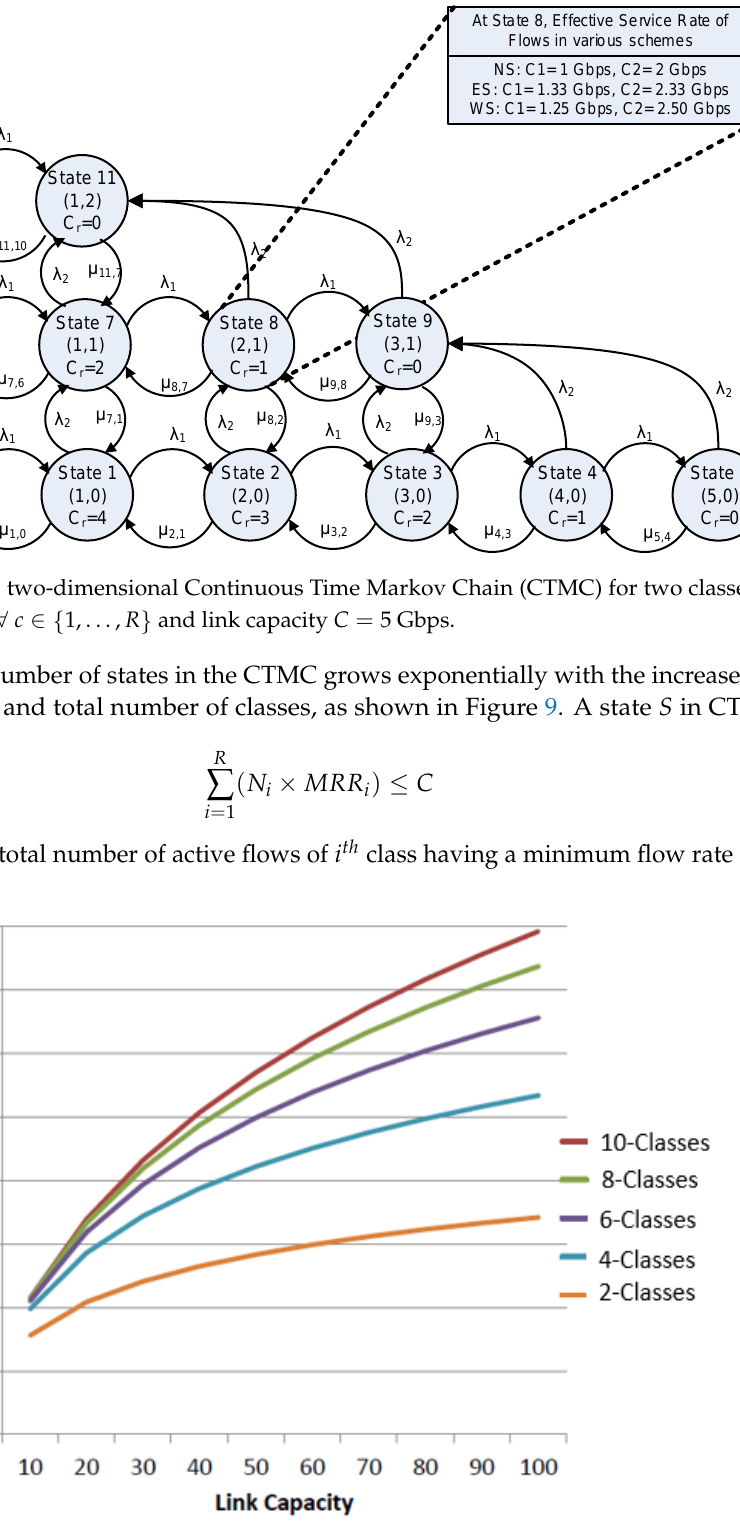
Figure 9. Impact of link capacity on number of states in CTMC with varying number of classes in the